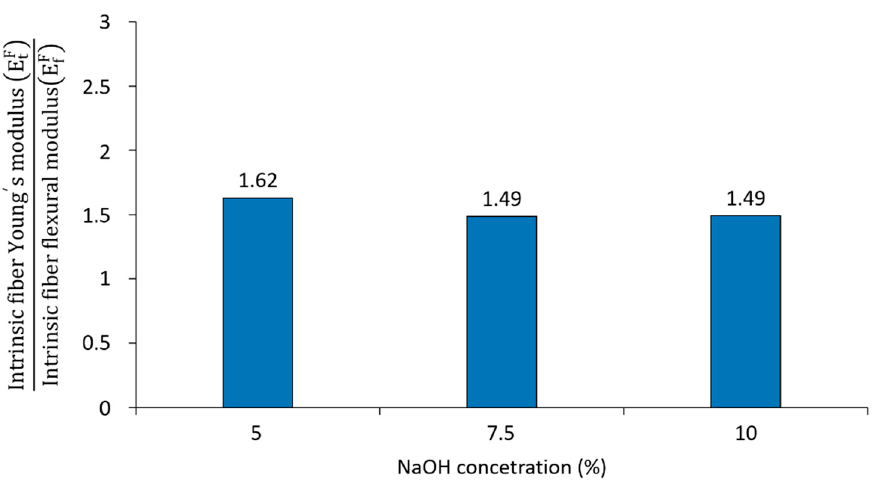
Figure 11. Relationship between the fiber intrinsic tensile modulus and intrinsic flexural modulus at different NaOH concentrations. Table 4. Modulus e ffi ciency factor ( η e ), length e ffi ciency factor ( η l ), orientation e ffi ciency factor ( η o ), limit angle ( α o ), mean orientation angle ( α